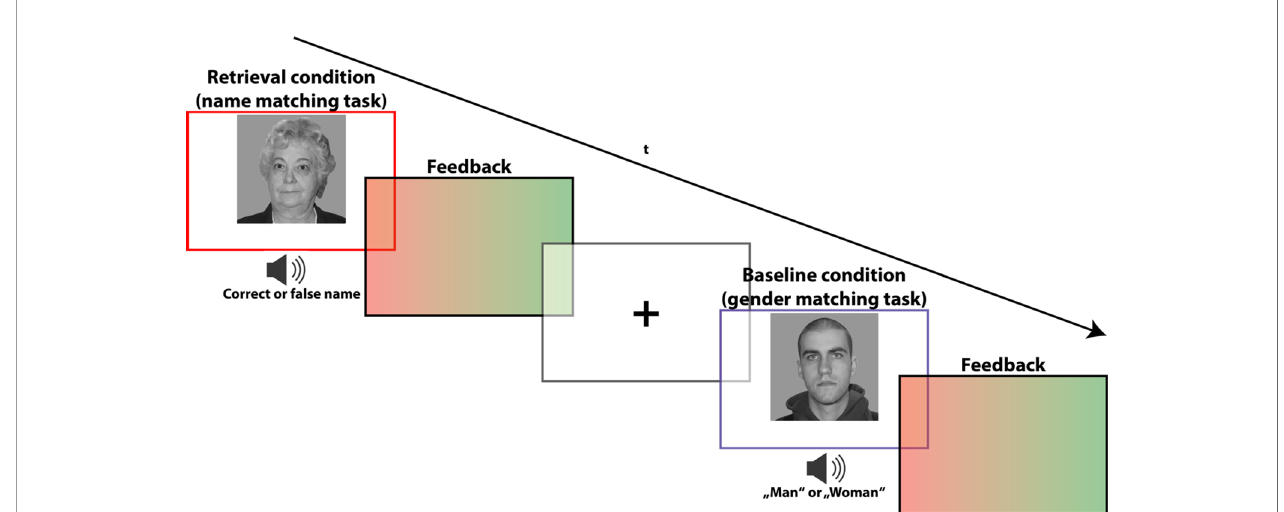
FIGURE 2 | fMRI paradigm for memory retrieval: task to recall (i.e., verify) the names of the faces from the contingent combinations. During the genuine memory trials (indicated by a red frame), subjects were asked to indicate whether the spoken name indeed corresponds to the presented face, or not. During “ no-memory ” baseline trials (indicated by a blue frame), subjects were instructed to indicate whether the spoken sex label ( “ man ” or “ woman ” ) matches the face ’ s gender. Stimuli appeared for 2,500 ms and were followed by a visual feedback indicating a correct (green slide) or false (red slide) response. Trials were separated by a fi xation cross with jittering ranging from 500 to 900 ms. The depicted faces were taken from the life span database of adult facial stimuli (22,